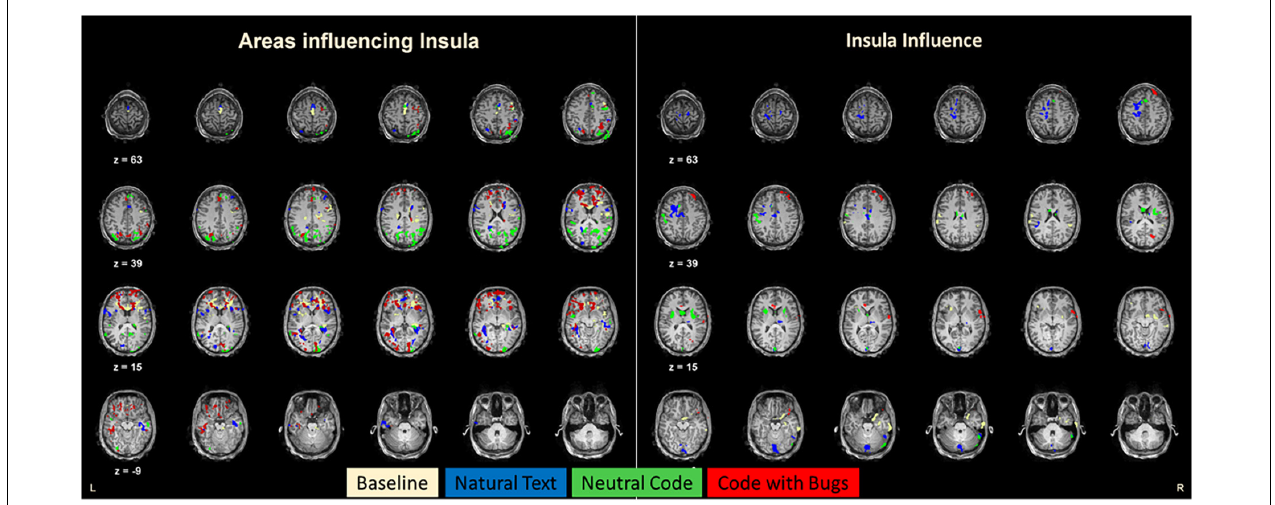
FIGURE 4 | Connectivity maps for the insula. The left panel represents the brain (Granger) connectivity map of regions that give input to the insula. The right panel shows the brain regions receiving input from the insula. In these maps, each color map represents each condition of the experiment. Notably, the “Code with bugs” condition recruits a larger set of areas to integrate with the insula, and these are located in more anterior regions of the brain compared to the other conditions that have more posterior connections. In sum, bug detection leads to an anterior shift of